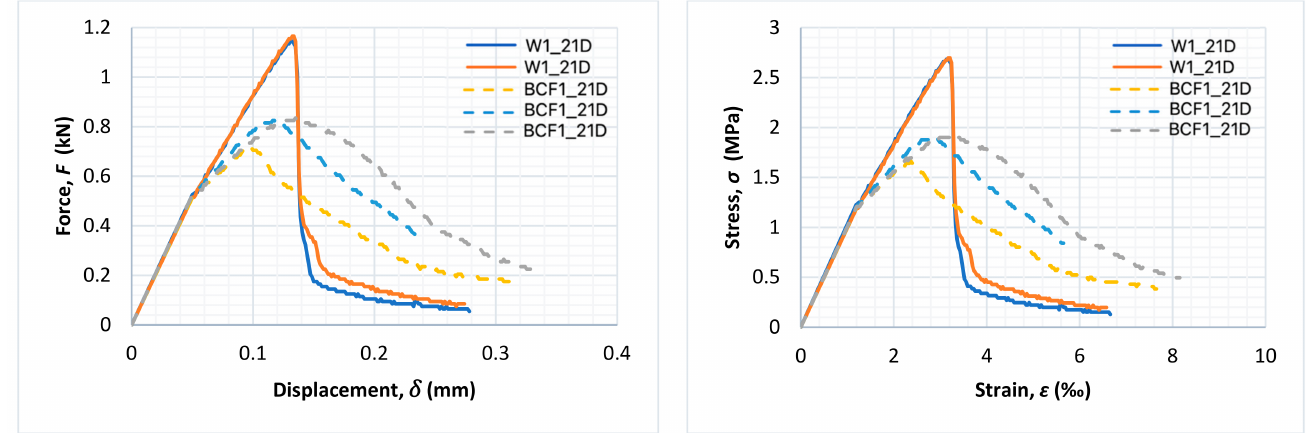
Figure 7. Force–displacement and stress–strain curves for the entire test duration for each specimen of series W1_21D (continuous line) and BCF1_21D (dashed line).